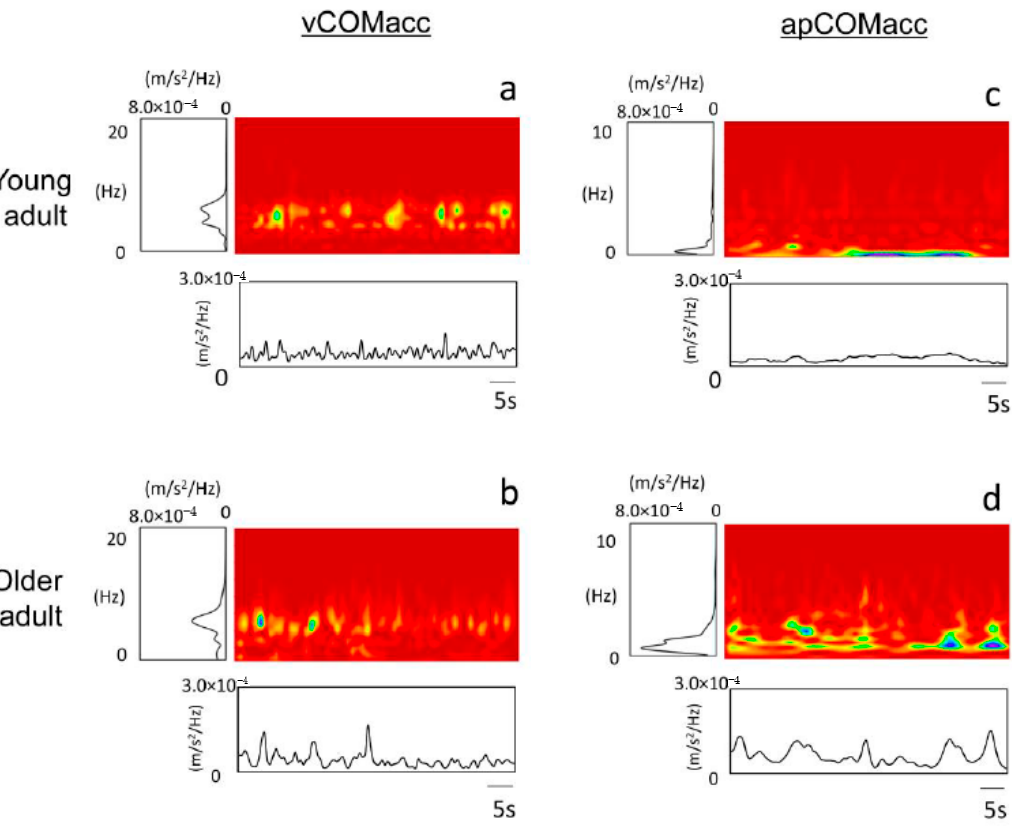
Figure 2. Examples of analysis in two-dimensional plots from continuous wavelet transform (CWT) of COMacc in young adults (panels ( a , c )) and older adults (panels ( b , d )). The power spectral density of the CWT shows the time-integrated square amplitude. Frequency domain analysis was normalized, and the power spectral densities were averaged across the 1 Hz band over the frequency range of 0–20 Hz for vCOMacc and 0–10 Hz for apCOMacc.